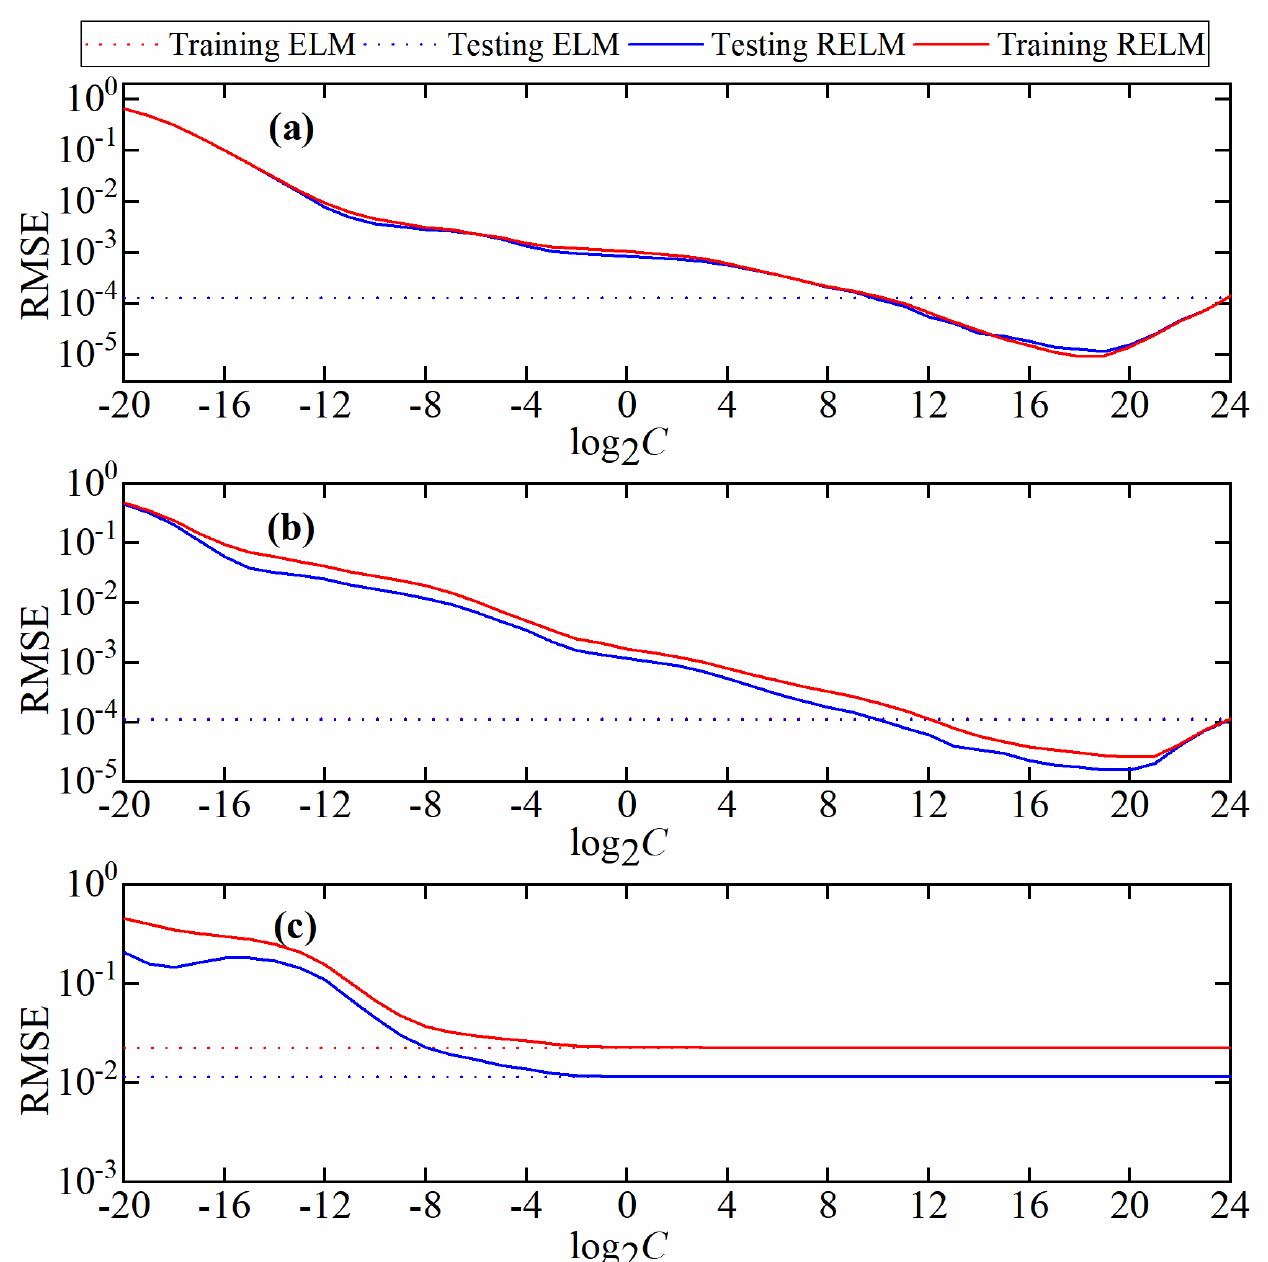
Figure 5. RMSE of the identification model when C is taken for different values: ( a ) output speed signal; ( b ) exhaust temperature signal; ( c ) output power signal. Table 1. FOS_RELM algorithm parameter